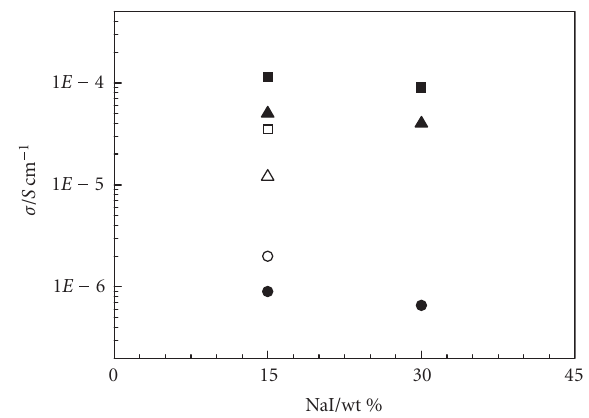
Figure 4: J-V curves obtained under 100 mWcm − 2 polychromatic irradiation for dye-sensitized solar cells assembled with polymer electrolyte (P(EO-EPI)87 : 13 + 15 wt% NaI / I 2 + GBL), with dif- ferent active areas: (—) 0 . 25 cm 2 , ( −−− ) 1 cm 2 , and ( (cid:3) ) 4 . 5cm 2